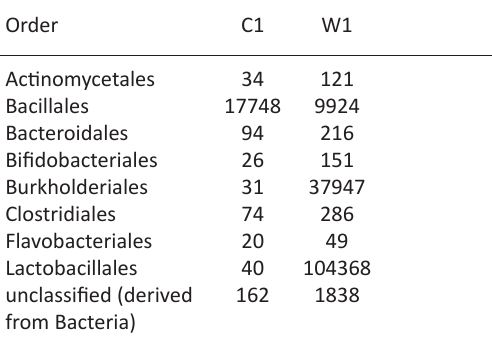
Table 6. Taxa Statistics at Order level Table 7. Taxa Statistics at Family